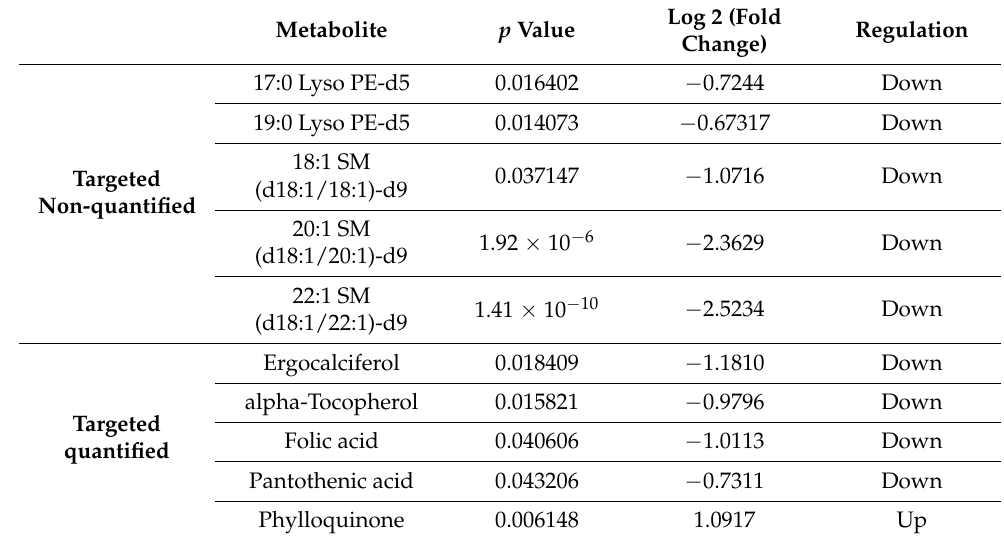
Figure 3. Chemical structure classification of the identified molecules. Table 3. Targeted metabolites differed significantly in NASH-HCC as compared to NASH